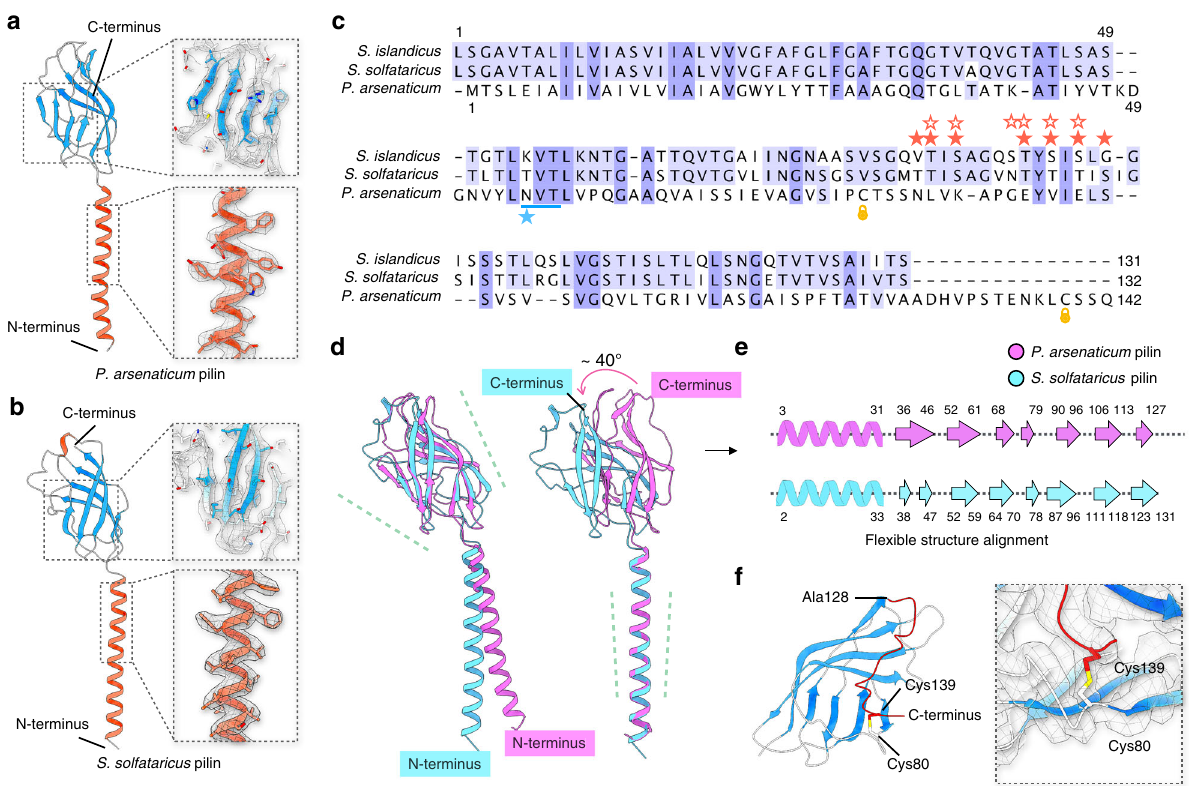
Fig. 2 Two-domain architecture of archaeal type IV pilus (T4P). Protein C α trace of a single P. arsenaticum pilin ( a ) and S. solfataricus pilin ( b ). Pilin structures are shown in cartoon, colored by secondary structure. The map quality of the N-terminal long helix and C-terminal globular domain are shown on the right. c Structure-based sequence alignments of three archaeal type IV pilins with known structures, P. arsenaticum pilin, S. solfataricus pilin and previously determined S. islandicus pilin. Sequences were aligned using Tcoffee 67 and visualized with Jalview 68 . The two blue shades correspond to the amount of sequence identity (dark blue when all three are identical, light blue when two are identical). The observed glycosylated residues are indicated with stars: solid red stars for O-linked sugars in S. solfataricus , open red stars for O-linked sugars in S. islandicus , and a blue star for N-linked sugar in P. arsenaticum . The blue line above the star indicates the NxS/T motif associated with N-linked glycosylation in P. arsenaticum . Two cysteine residues that form a disul fi de bond in P. arsenaticum are indicated with yellow lock symbols. Note that amino acid positions are counted starting with the fi rst amino acid of the mature protein (i.e., following cleavage of the signal peptide). d Superposition of a single P. arsenaticum pilin (purple) and S. solfataricus pilin (cyan), aligned by either the globular domain (left) or the N-terminal helix (right). e Flexible secondary structure alignment reveals a simple mapping of the local secondary structure elements between the two pilins. The N-terminal domain is α -helical, and each β -strand in the C-terminal domain is shown as a closed shape. f The C-terminal loop of the P. arsenaticum pilin and the disul fi de